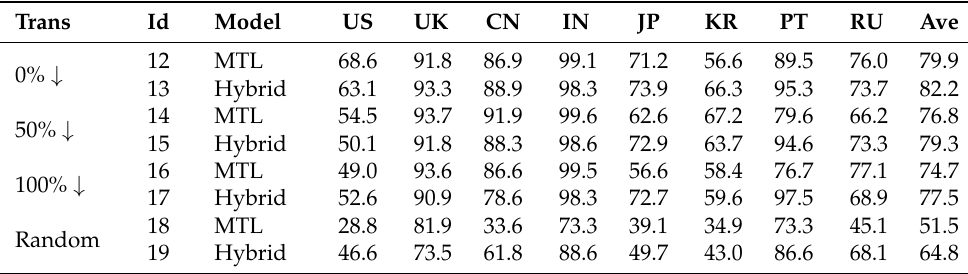
Table 3. Accuracy for the robustness test under different transcription situations. For example, “50% ↓ ” suggests that θ = 0.5 (i.e., 50% of the transcriptions are messed). All models use λ = 0.1. For the hybrid version, we use the channel-attention-based fusion (Figure 2c). Please note that Id 12, 13 is in fact the same as Id 6, 11 in Table 2, correspondingly.